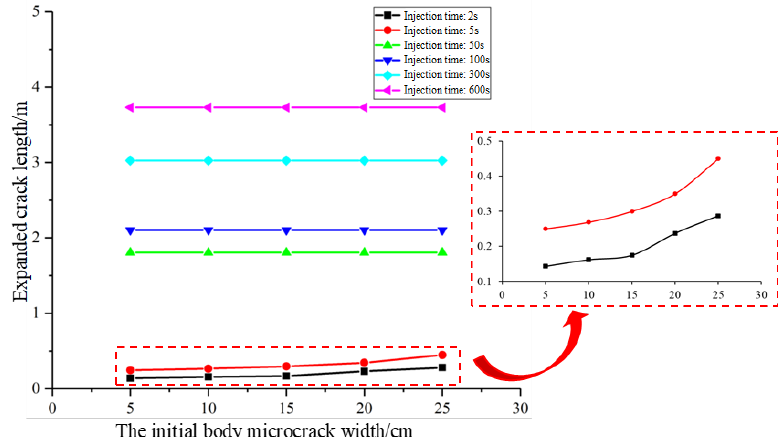
Figure 14. The e ff ect of the initial microcrack length on expanded crack length at di ff erent injection times. Figure 14. The effect of the initial microcrack length on expanded crack length at different injection times.